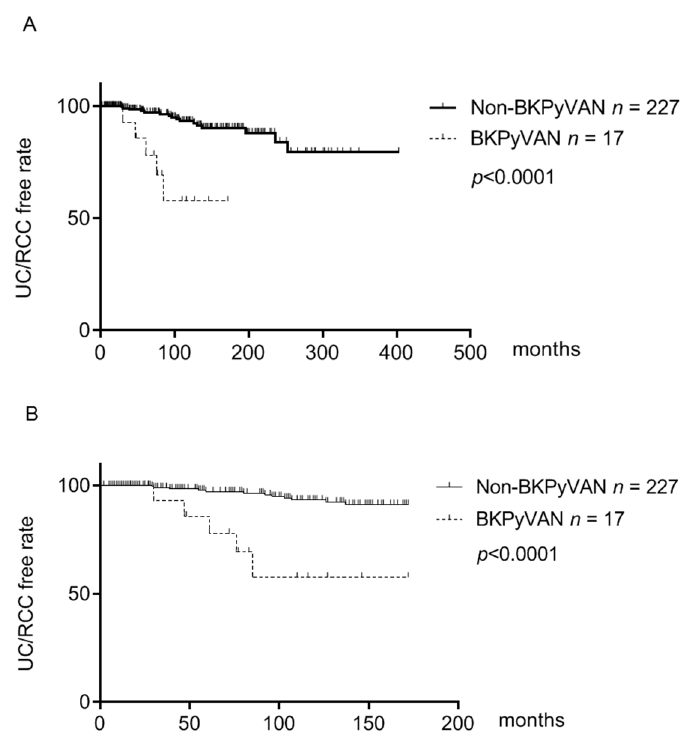
Figure 2. Kaplan–Meier analysis of urinary tract cancer-free survival in patients with and without BKVAN. ( A ) Urinary tract cancer (urothelial carcinoma (UC) and renal cell carcinoma (RCC))-free survival in patients with and without BKPyVAN and non-BKPyVAN was determined by Kaplan–Meier analysis. ( B ) As the longest observation period was 172 months in patients with BKPyVAN, urinary tract cancer-free survival within 172 months in two groups was assessed by Kaplan–Meier analysis.